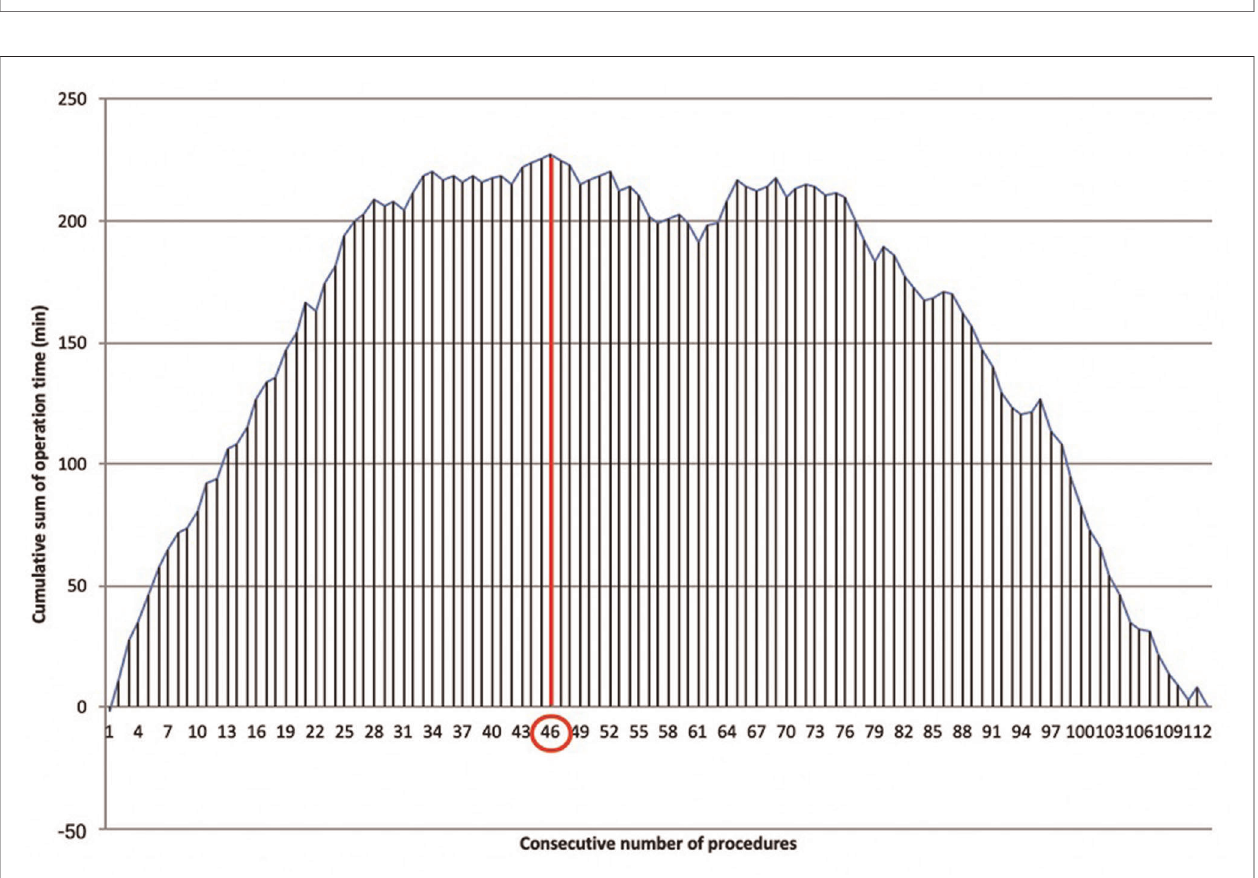
FIGURE 5 | Bernoulli cumulative deviation curves for CUSUM. ( A ) Myasthenic patients; ( B ) non-myasthenic patients. The blue circle is the point where mastery was reached.